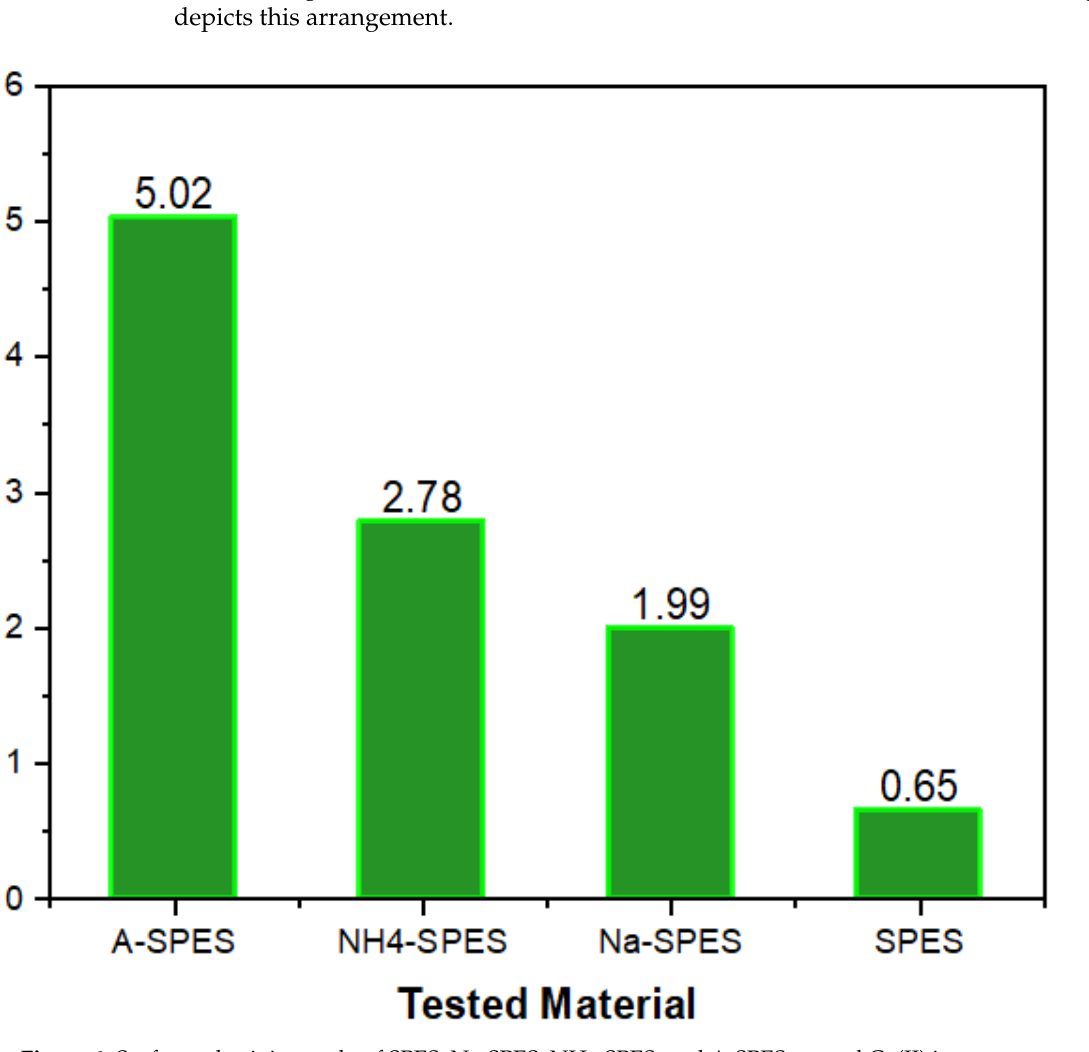
Figure 6. Surface selectivity study of SPES, Na-SPES, NH 4 -SPES, and A-SPES toward Co(II) ions.